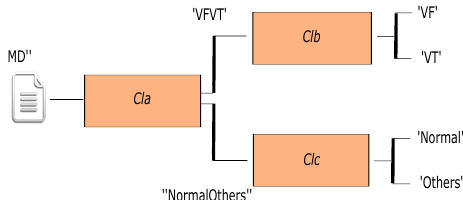
Figure 5. Hierarchical topology classifier. Multi-class classification is obtained by joining several binary